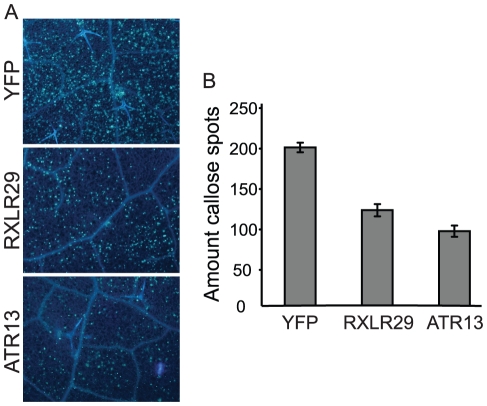
RXLR29 suppresses callose deposition in bacteria-inoculated Arabidopsis leaves.Five-week-old Col-0 leaves were hand-infiltrated with 1×108 cfu/ml Pst DC3000ΔCEL carrying YFP, RXLR29 or ATR13, as indicated. Leaf samples were taken at 12 h after infection and stained with aniline blue to visualize callose (A). The number of callose spots was quantified in each sample (B). The experiment was repeated three times with similar results.